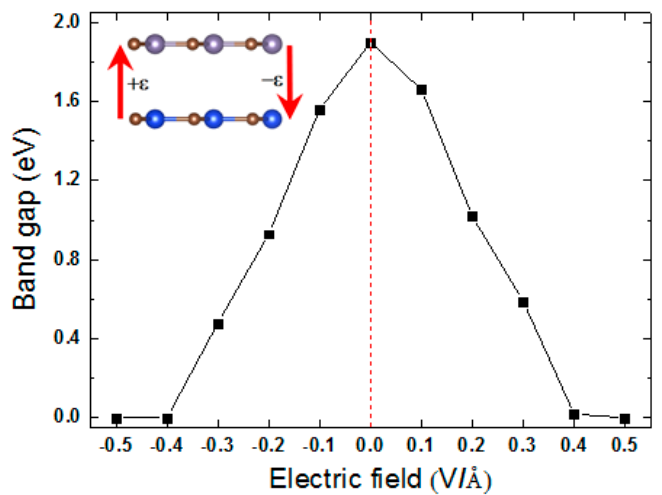
Figure 5. (Color online) Energy bandgap of the SiC / GeC vdW heterostructures as a function of the external electric field.